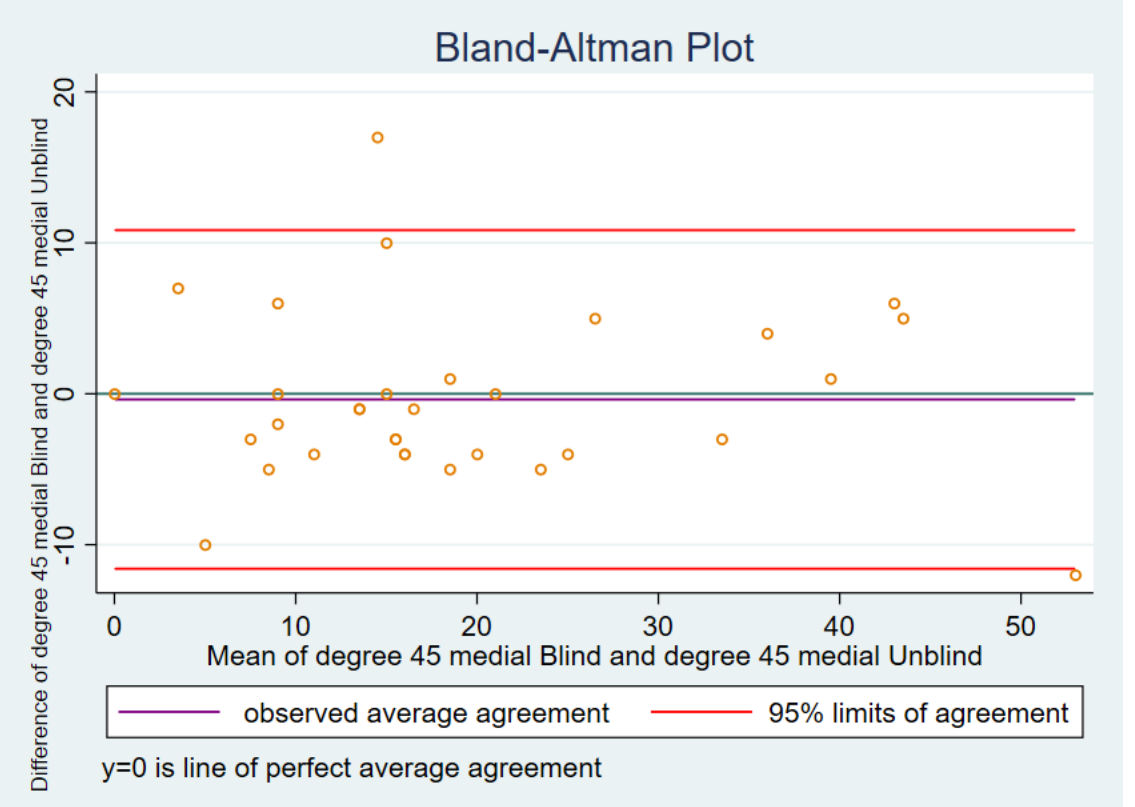
Figure A6. Forty-five degrees, medial.